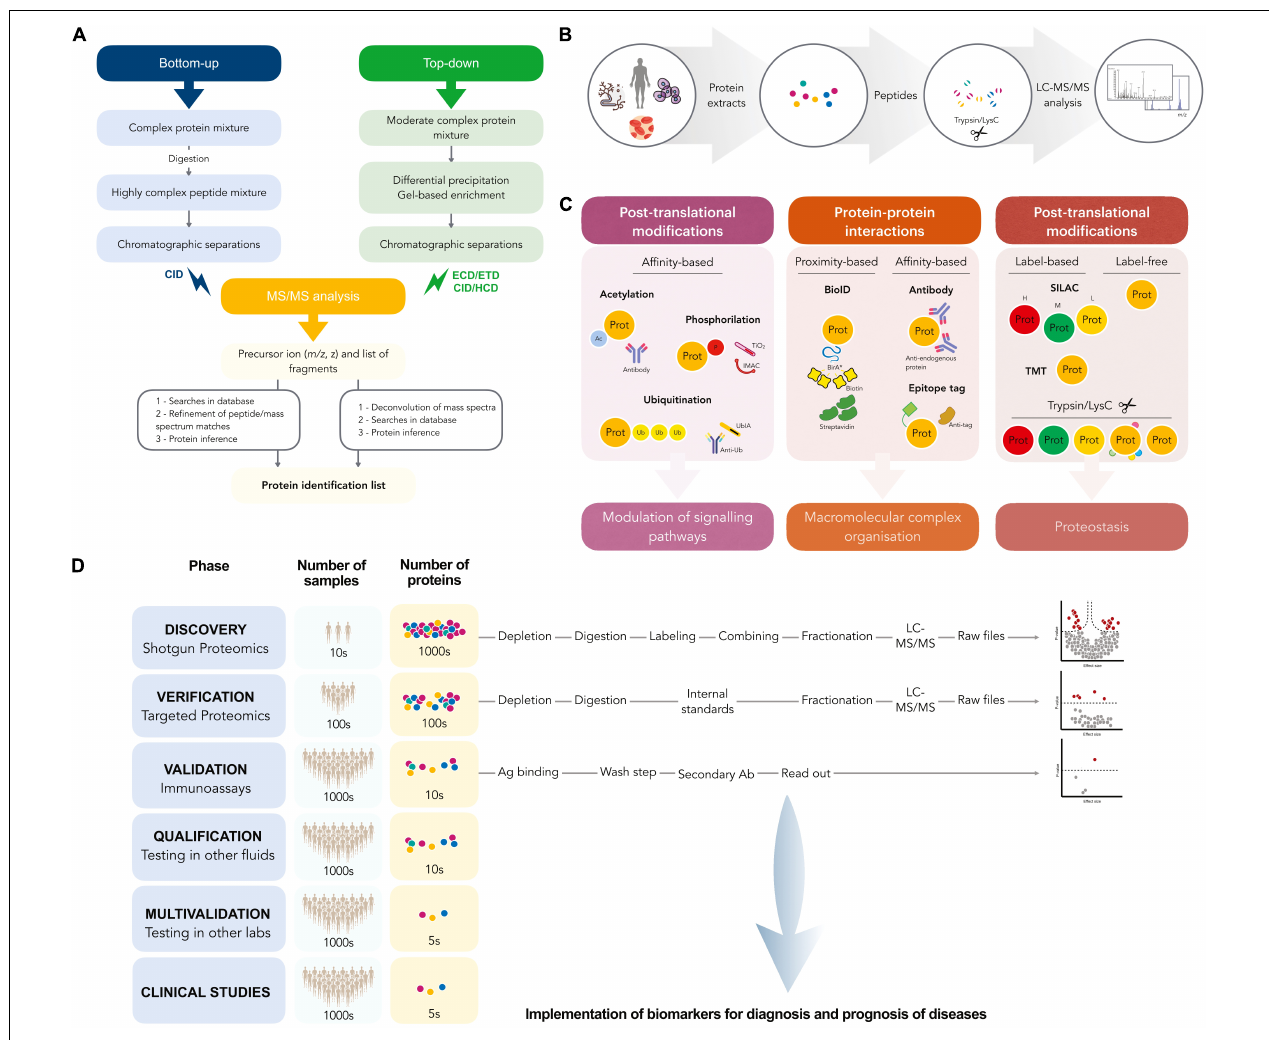
FIGURE 1 | (A) Work-flow followed in bottom-up and top-down proteomics. (B) A schematic workflow for prototypical bottom-up proteomics experiments. Protein lysates from infected biological samples, are digested by trypsin and/or LysC, and the resulting proteolytic peptides are analyzed by LC-MS/MS. (C) Applications and main features of different bottom-up proteomics workflows, label-free or label-based SILAC, and tandem mass tag MS methods applied for global proteome profiling. Workflows can be also coupled with affinity purification-based methods to elucidate host-pathogen PPI networks. (D) Workflow for discovery and validation of